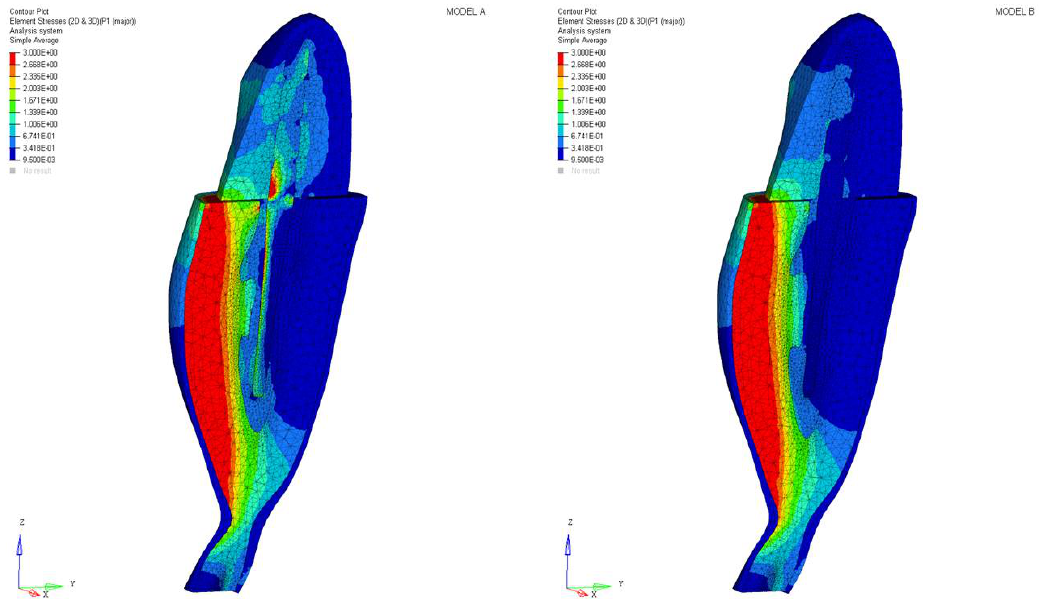
Figure 2. Maximum principal stress distribution (MPa): model A and model B.